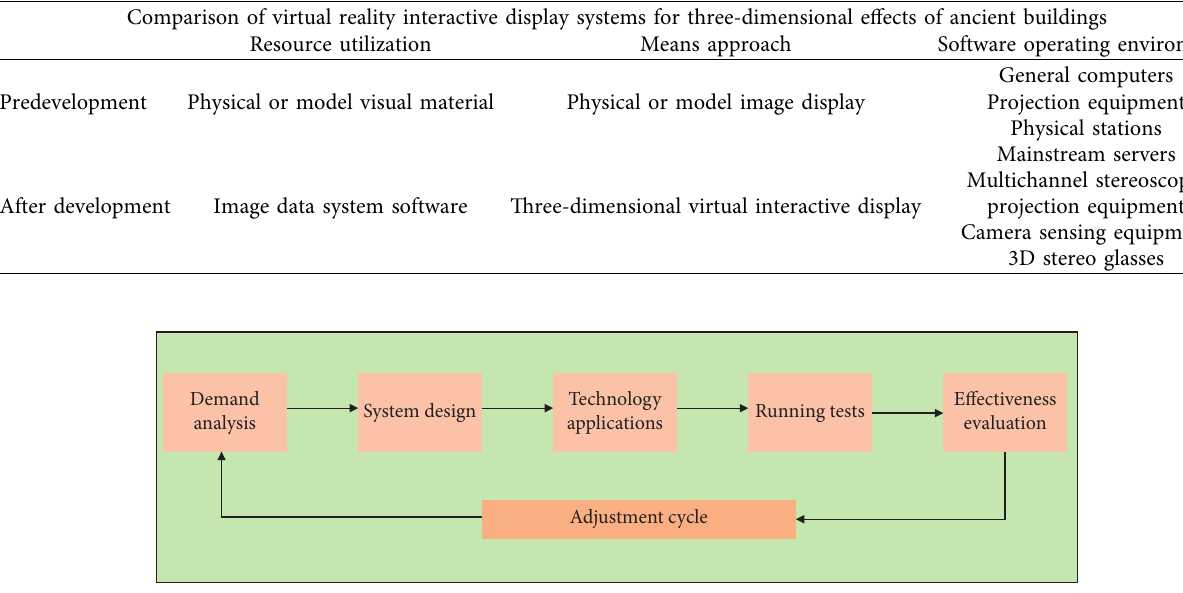
Figure 3: Procedures of system design and